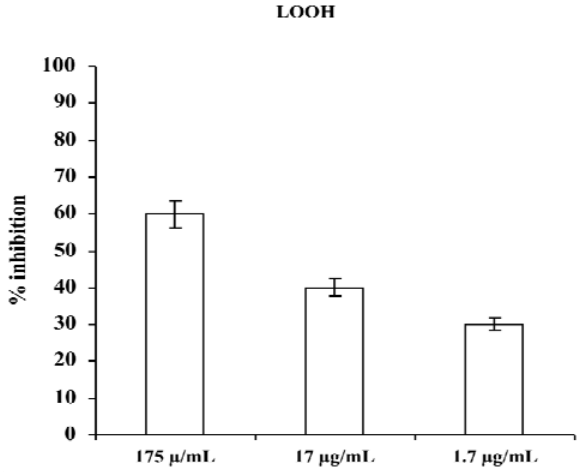
Figure 2. Effect of aqueous extract of M. foetida Schumach. et Thonn. on LOOH production in plasma; results are expressed as percentage of inhibition of LOOH formation with respect to the same sample incubated in absence of the extract. Each value represents the mean ± SD of five experimental